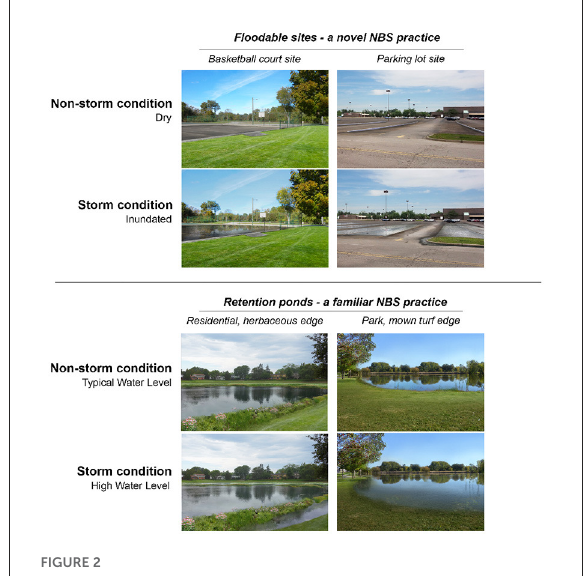
FIGURE2 Examples of visualizations for floodable sites, a novel NBS practice, and retention ponds, a familiar practice, under storm and non-storm conditions. Image credit: The Landscape Ecology, Perception, and Design Lab, University of Michigan